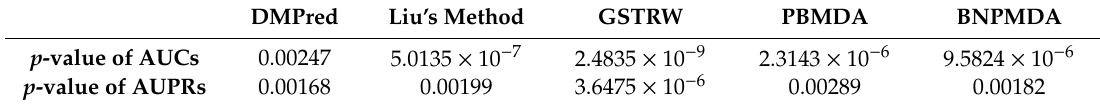
Table 3. Comparison of di ff erent methods based on AUC and AUPR with a paired t -test.